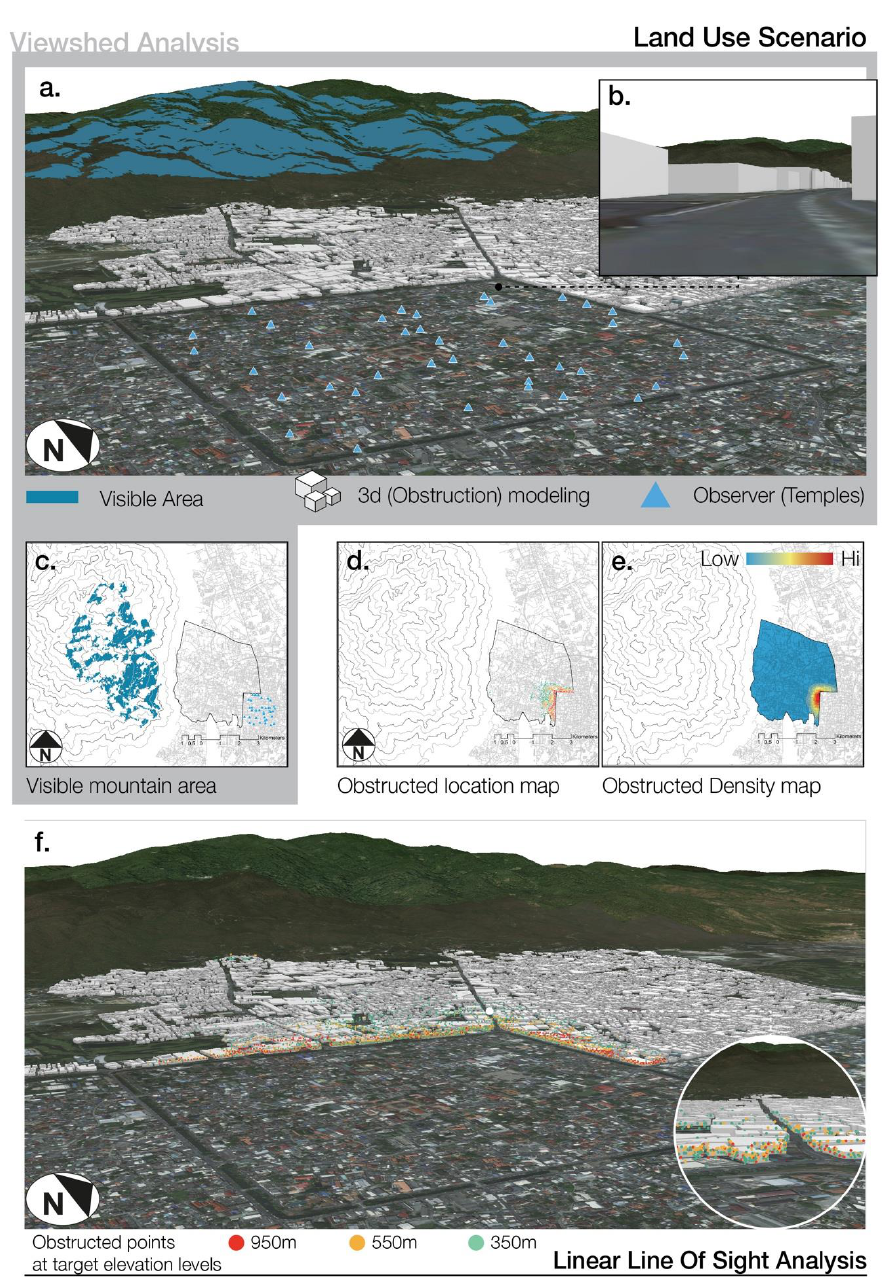
Figure 12. Results of the Land Use Scenario ( a ) Viewshed result in 3D ( b ) A sample view at human eye-level ( c ) Viewshed map ( d ) Obstructed location map ( e ) Obstructed density map ( f ) Obstructed locations at three elevation levels (Source: Authors).